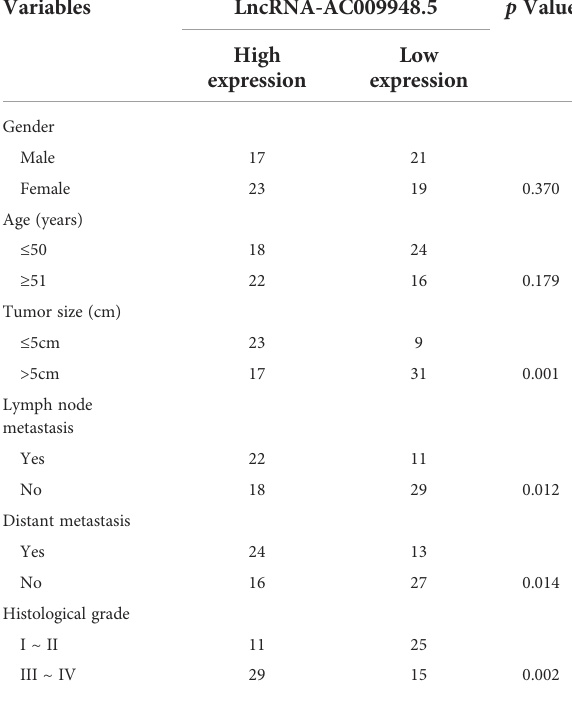
TABLE 1 Correlation between the clinical pathologic features and expression of LncRNA-AC009948.5.